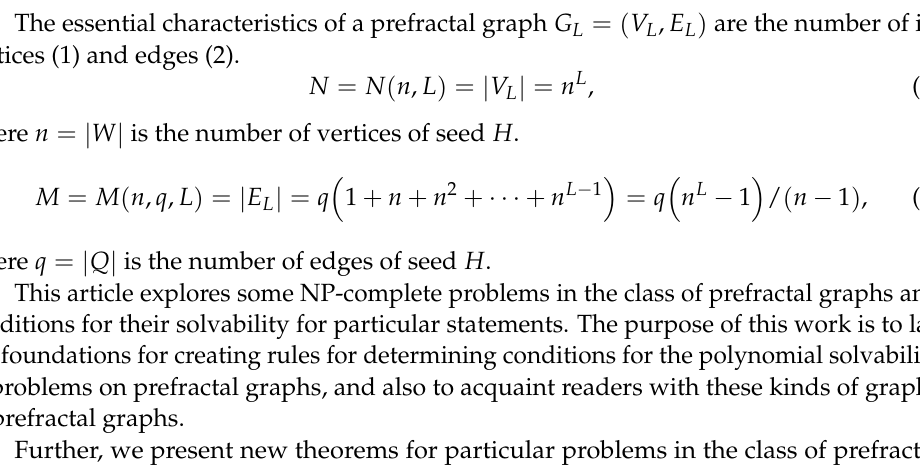
= ((cid:1848) , (cid:1831) ) are the number of its (cid:3013) (cid:3013) (cid:3013)